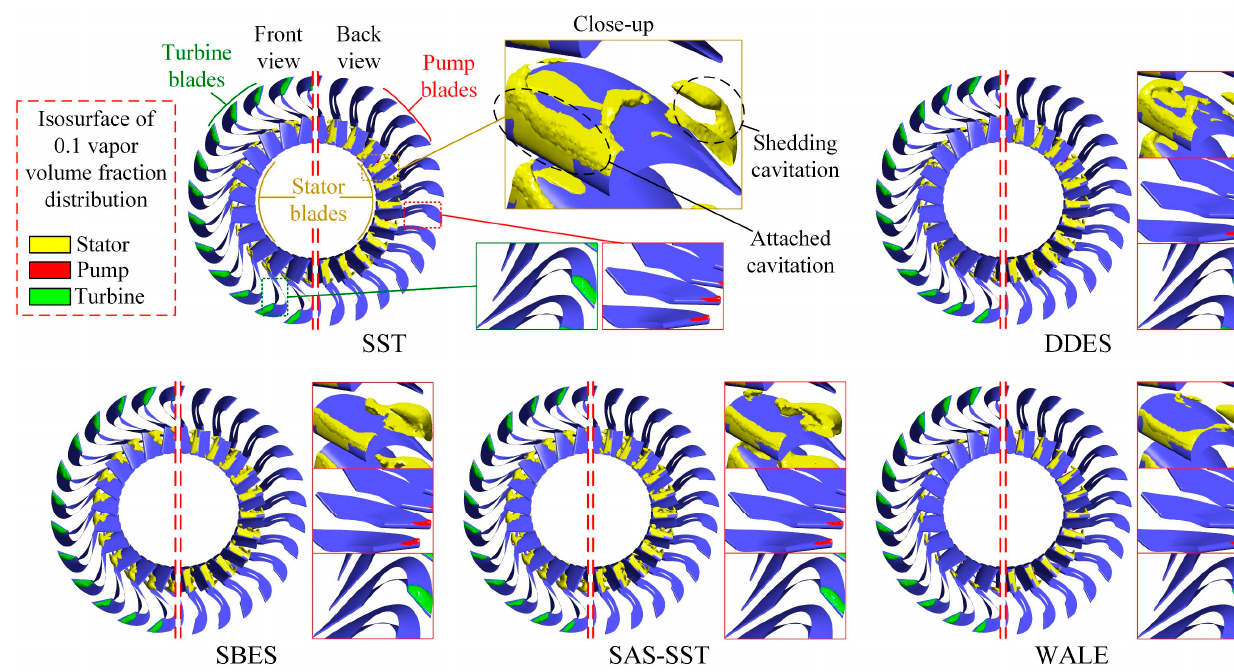
Figure 12. Time-averaged cavitation in di ff erent domains under various models ( SR = 0.01).